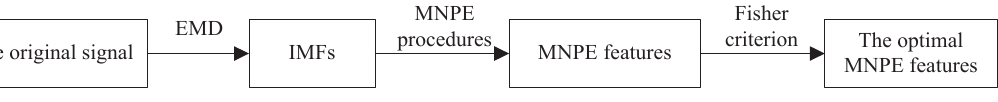
Figure 4. The procedures of the hybrid feature extraction method.